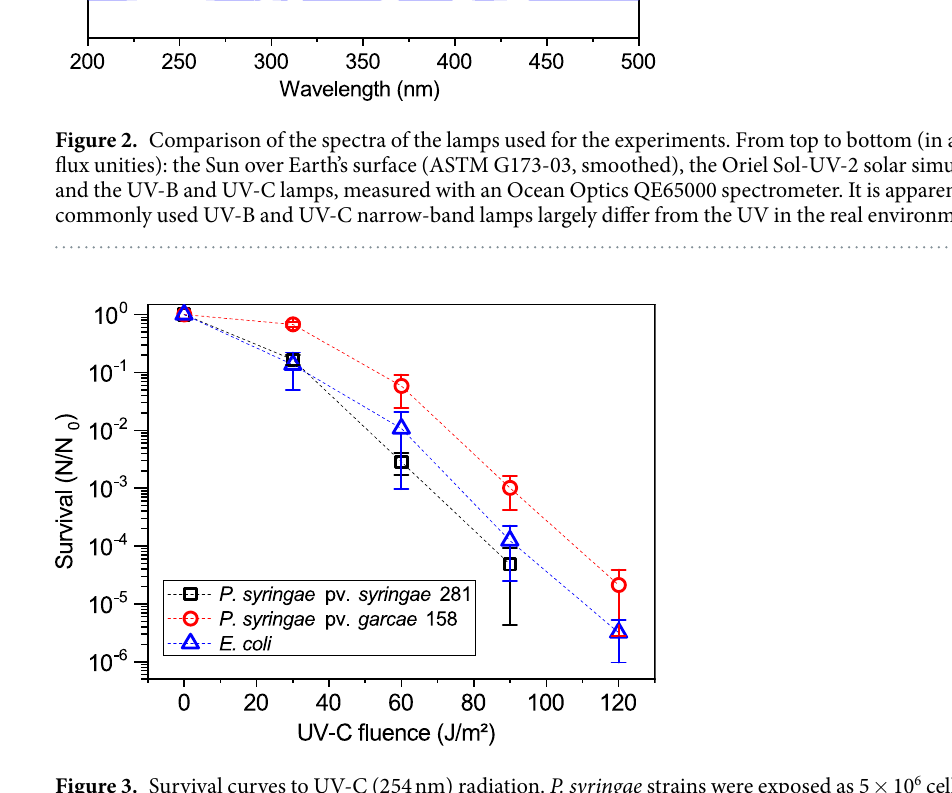
Figure 3. Survival curves to UV-C (254 nm) radiation. P. syringae strains were exposed as 5 × 10 6 cells/ml suspensions, and E. coli as 5 × 10 7 cells/ml. P. syringae pv. syringae 281 and P. syringae pv. garcae 158 are